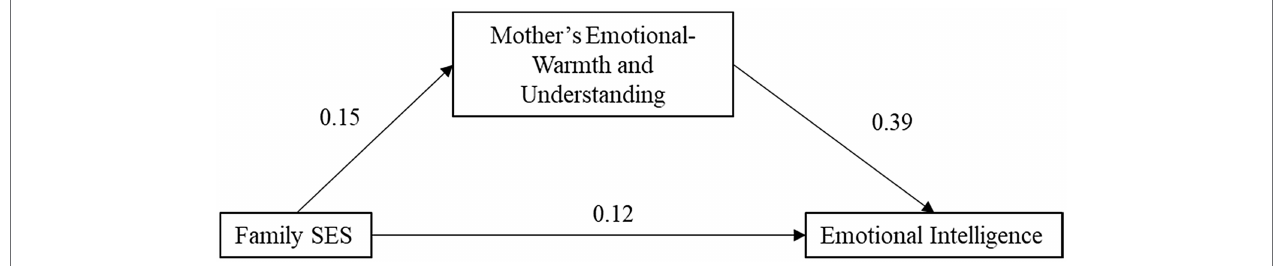
FIGURE 5 | A model diagram of the mediating effect of mother’s emotional warmth and understanding in total primary school students.